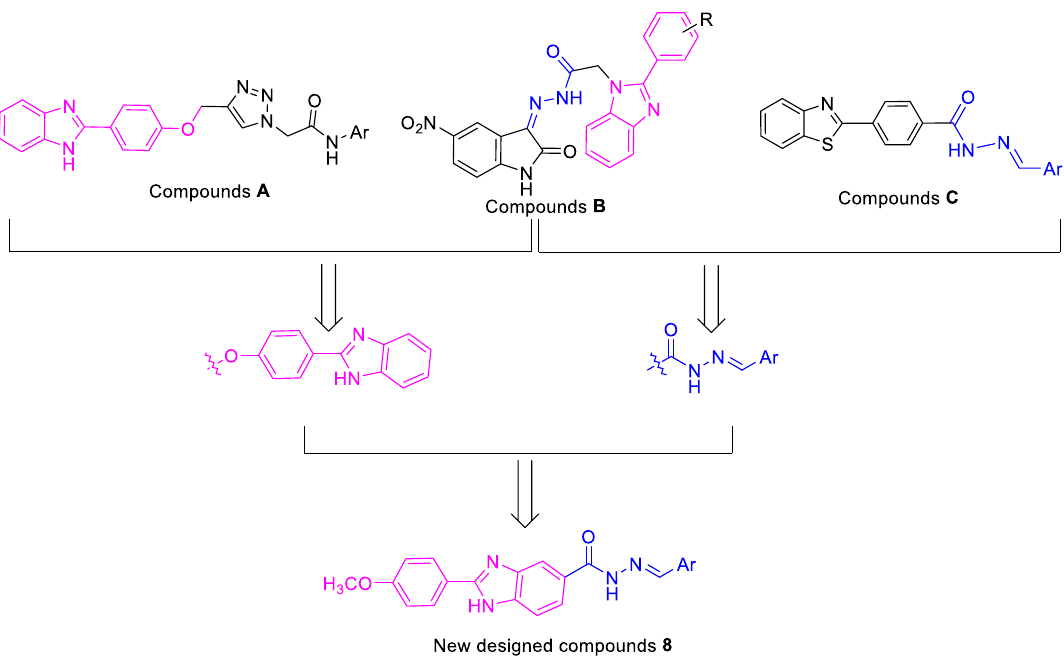
Figure 1. Design strategy for new benzimidazole-Schiff base hybrids 8 as the potent